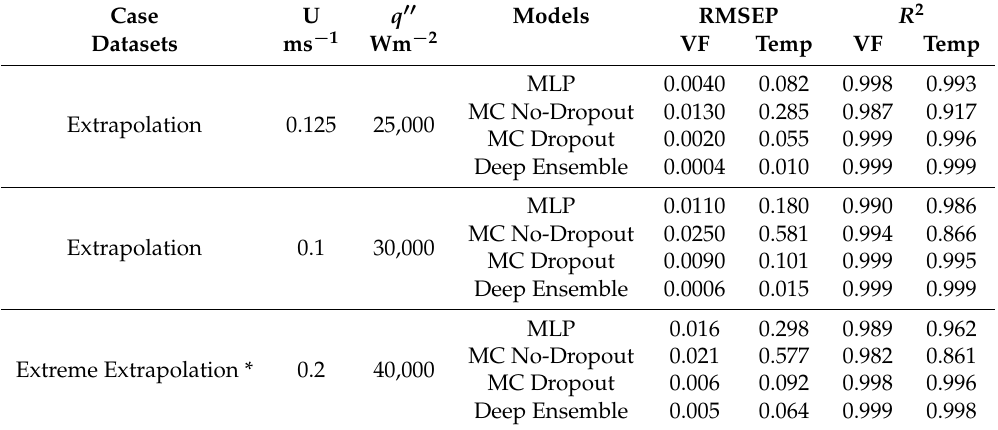
Table 7. Performance of the models tested on extrapolation dataset, VF: Void Fraction, Temp: Temperature. Extreme Extrapolation * is the tested data presented in the